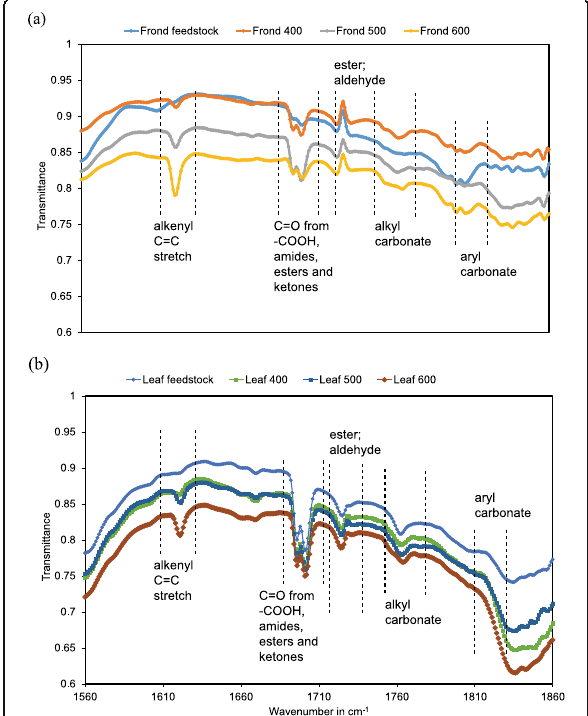
Fig. 3 FT-IR for feedstocks and biochar pyrolyzed at 400 – 600 °C for a frond and b